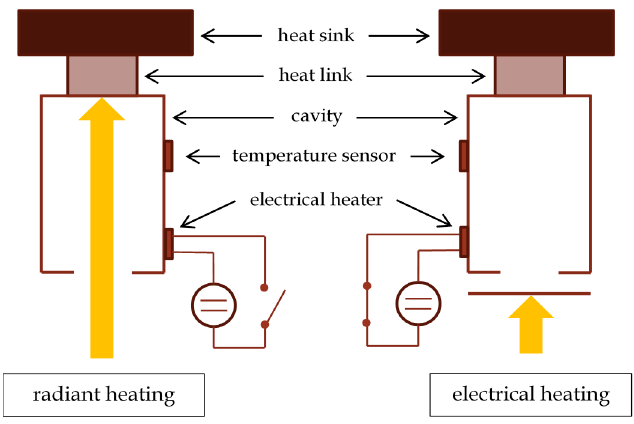
Figure 4. Operating principle of electrical substitution radiometers.